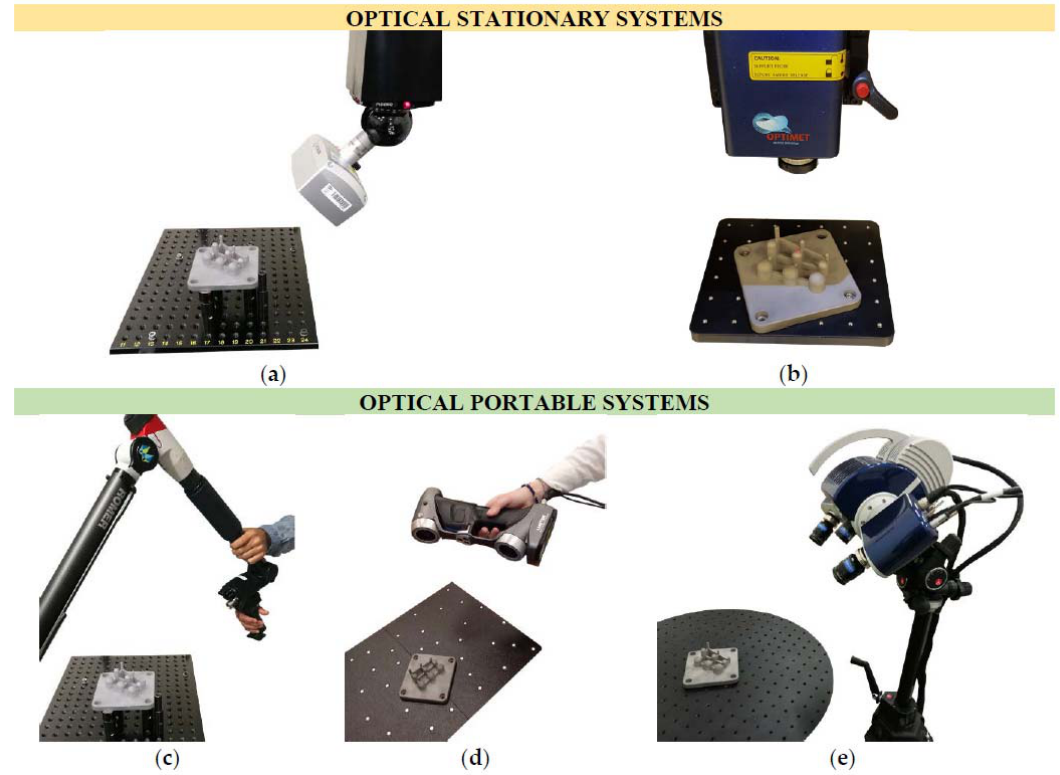
Figure 5. Optical measurement of the test part using stationary systems: ( a ) a laser scanner on a coordinate measuring machine (LS-CMM) and ( b ) a conoscopic holography (CH) sensor; and portable systems: ( c ) a laser scanner on a coordinate measuring arm (LS-CMA), ( d ) a handheld laser scanner (HLS), and ( e ) a structured light (SL) scanner.